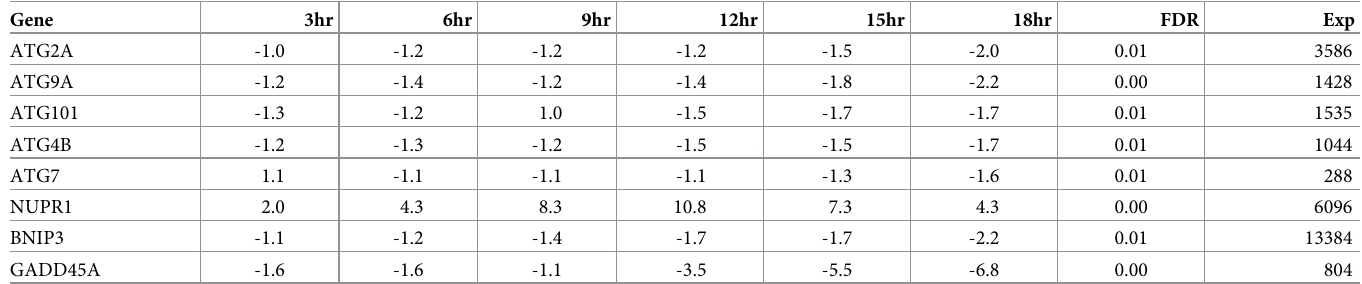
Table 8. Differential expression (fold = infected/non-infected) with a FDR less than 0.05 at one or more time points and the averaged expression level (Exp) of autophagy and apoptosis regulating genes between infected and non-infected macrophages at 3, 6, 9, 12, 15 and 18 hours post